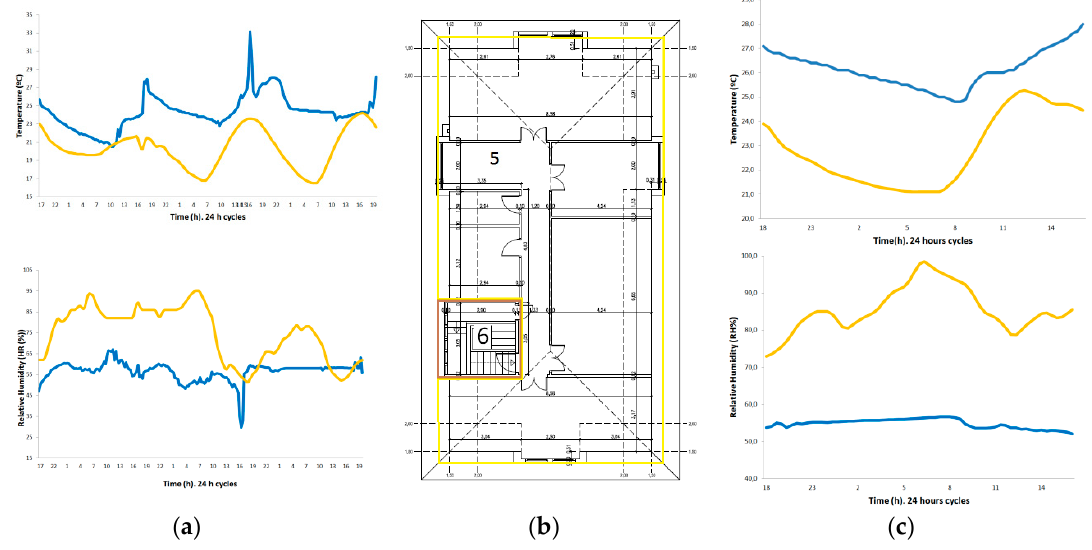
Figure 5. ( b ) Sections 5 and 6 , on the attic. T Indoor /RH Indoor (blue line) and T Outdoor /RH Outdoor (yellow line) evolution: ( a ) from 13 to 16 August 2016, at Section 5 ( b ) from 17 to 18 August 2016, at Section 6